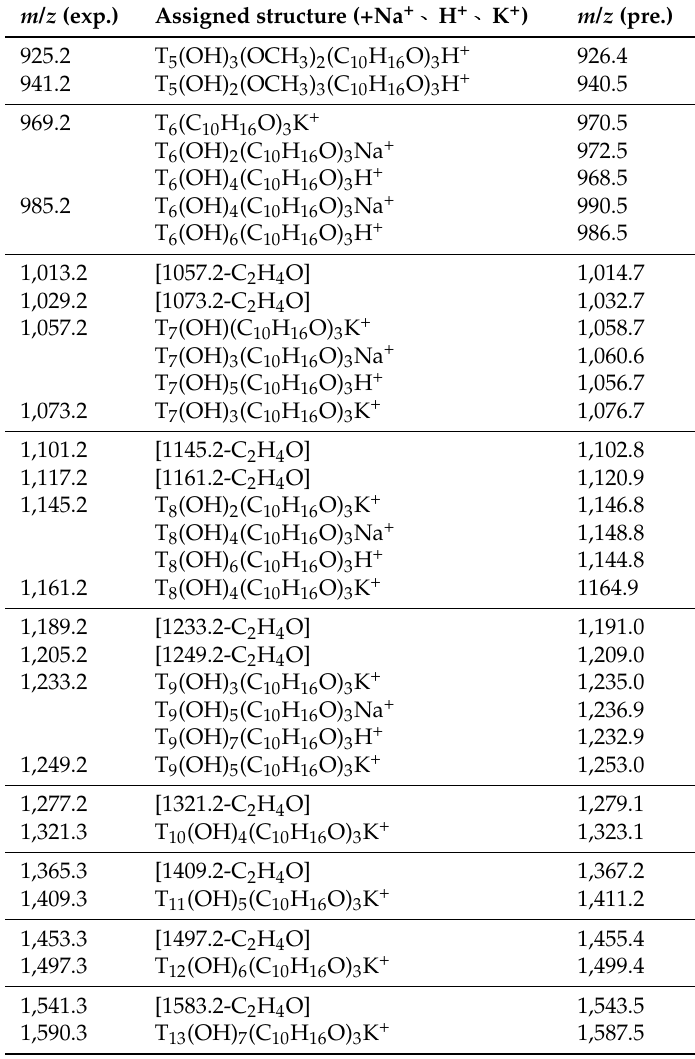
Table 1. VS-citral oligomers assigned by MS in the m / z = 925.2–1590.3 Da. m / z